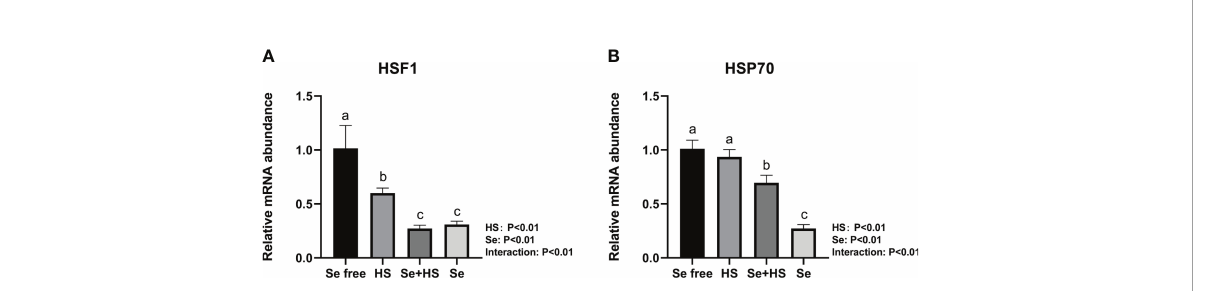
FIGURE 8 Effects of HMSeBA on the mRNA expression of heat stress related protein in mammary gland of mice under HS (n = 12). The relative mRNA expression levels of HSF1 (A) and HSP70 (B) were measured using real-time quantitative PCR. a-c Different lowercase letters indicate extremely signi fi cant differences between two groups ( P < 0.01), while the same lowercase letters indicate no signi fi cant difference between two groups ( P >